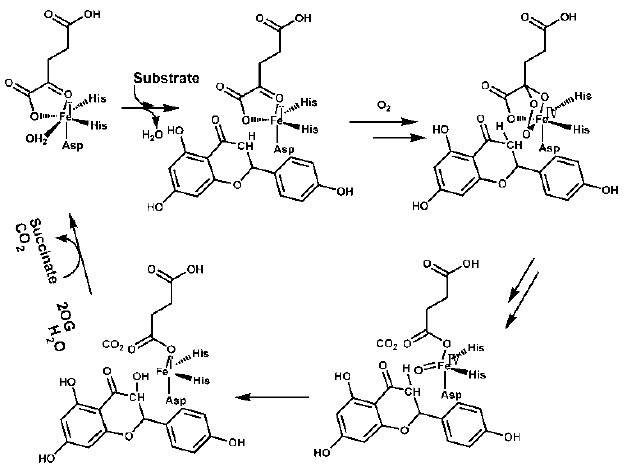
bound by the HX···H facial triad and the remaining coordination sites are occupied